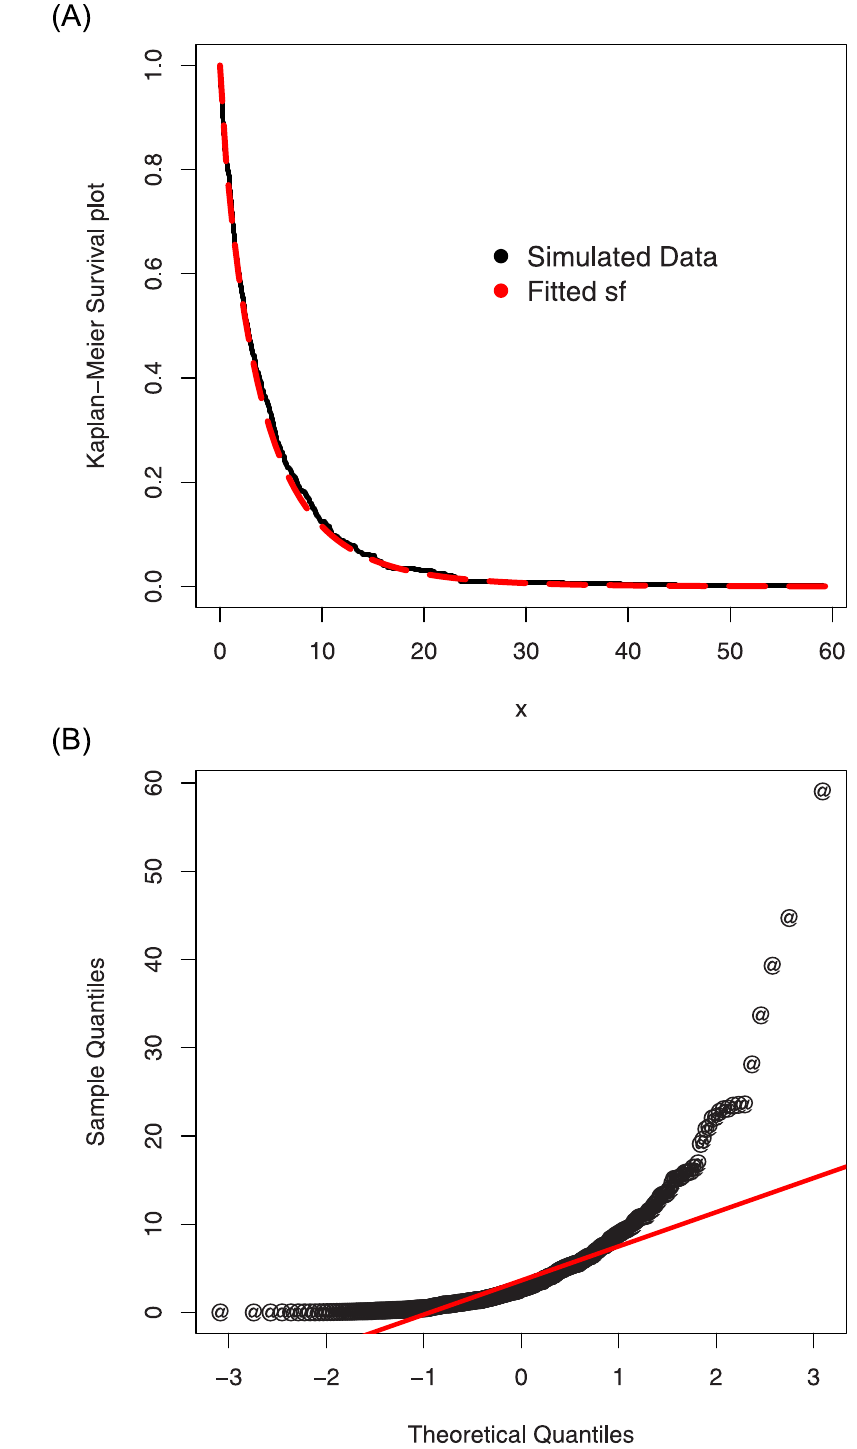
Fig 9. The QQ and Kaplan-Meier survival plots of the ASM-Weibull model for the simulated data set 1.